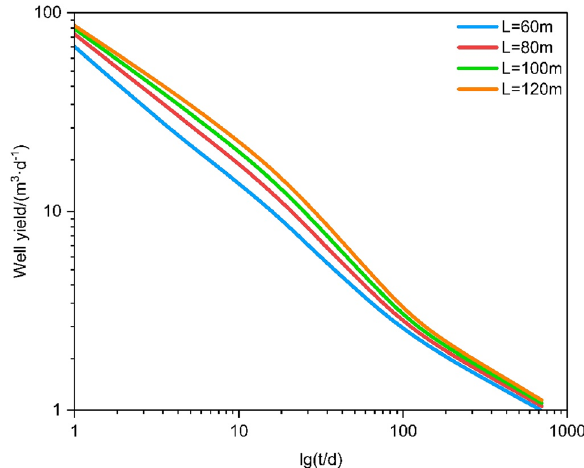
Fig. 10 Well production curves for different hydraulic fracture slit lengths